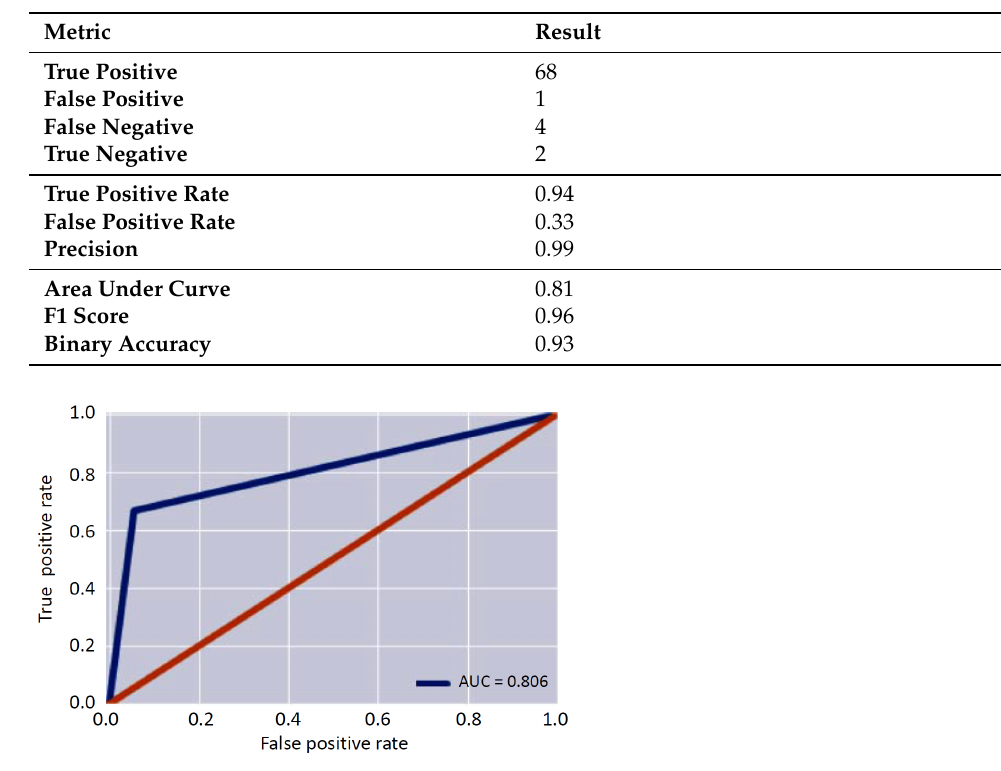
Figure 6. Reconstruction error (blue line) as a function of the training and test data. The identified threshold for the anomaly detection is shown in red. Table 2. Results of data classification.